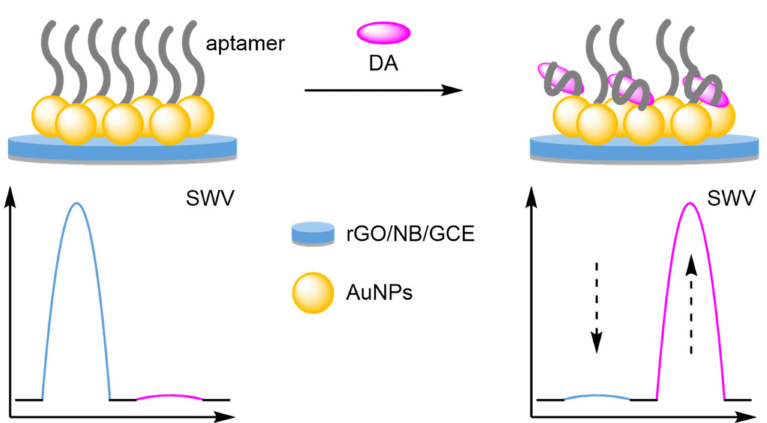
Figure 37. Schematic representation of an aptamer-based modified electrode for the detection of dopamine (DA).